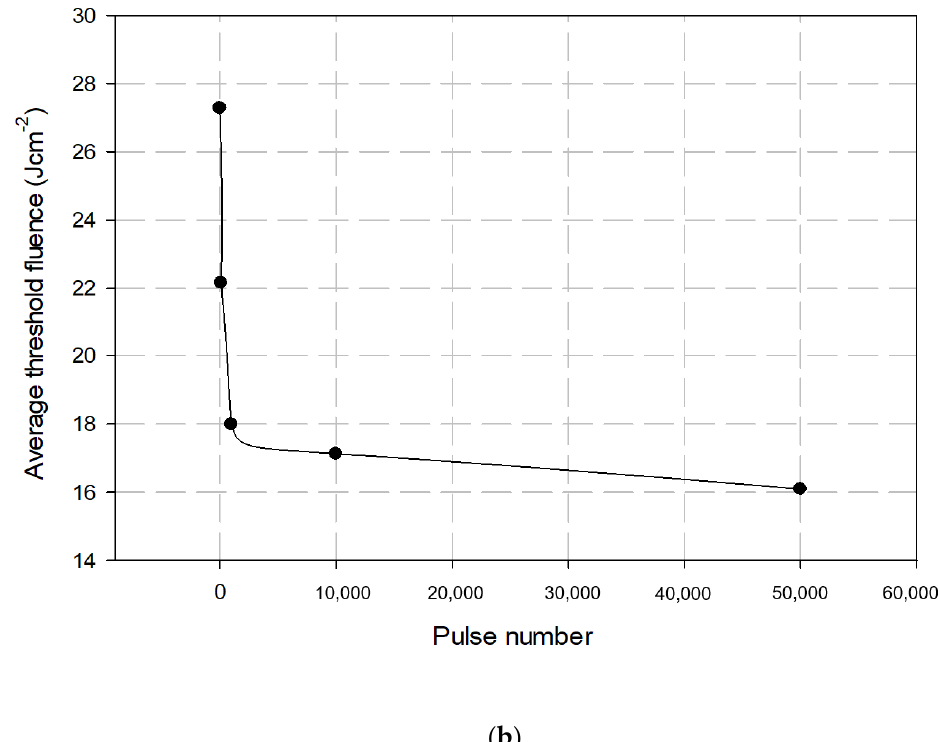
Figure 8. Graphs showing the surface average threshold fluence as a function of pulse number for ( a ) diamond and ( b ) sapphire.